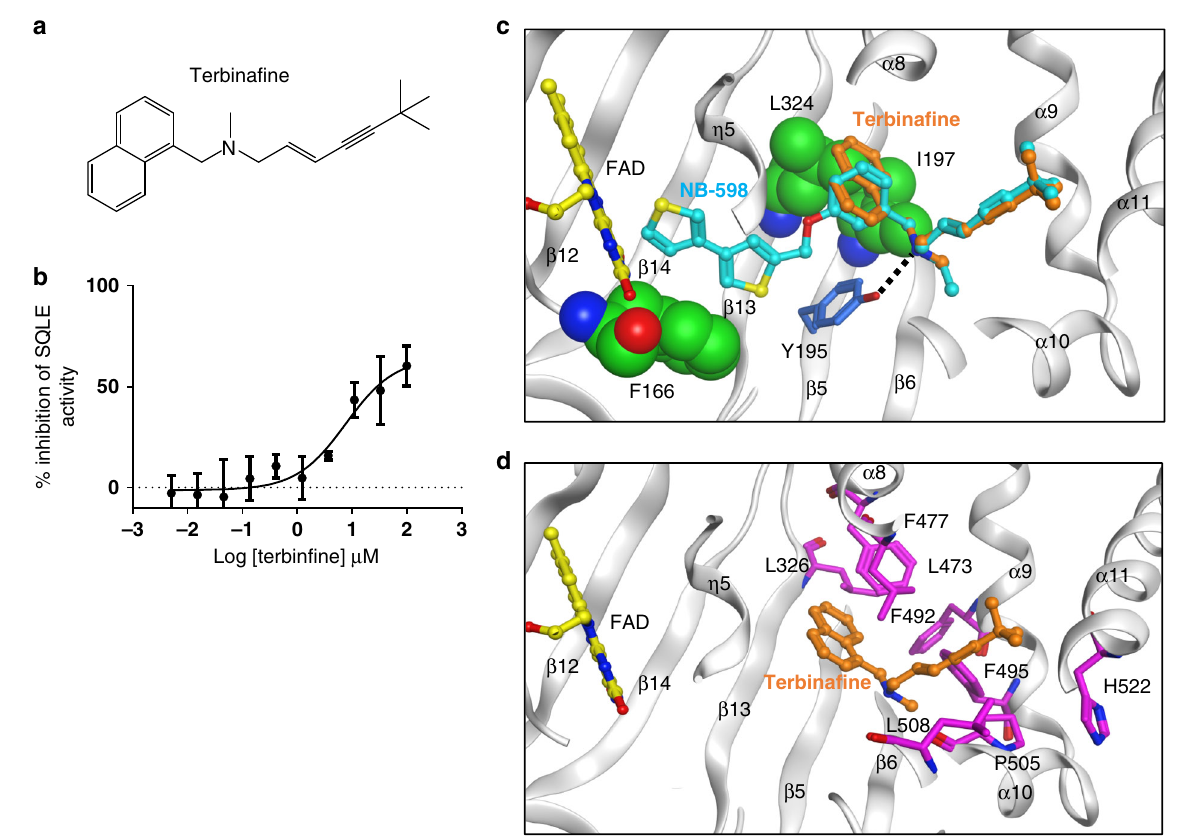
Fig. 3 Biochemical characterization of terbina fi ne, binding model and rationale for fungal drug resistance. a Structure of terbina fi ne. b Terbina fi ne is a weak partial inhibitor of human SQLE in the HLM assay. Relative IC 50 was determined to be 7.7 µ M with a maximal inhibition of 65% at 100 µ M inhibitor concentration. Error bars represent the standard deviations from a representative experiment performed in triplicate. c Superposition of terbina fi ne structural model with NB-598 using the SQLE (cid:129) FAD (cid:129) NB-598 complex. NB-598 (cyan), terbina fi ne (orange), and FAD (yellow) are shown in ball-and-sticks representation. Non-conserved amino acids in the inhibitor binding site is shown in CPK (green) and the Y195 residue that is conserved across species in stick (blue) representation. Hydrogen bond interaction between Y195 and the central amine moiety of inhibitors is shown as black dashed line. d Mapping of terbina fi ne-resistant mutations to the human SQLE structure with superposed terbina fi ne model. Equivalent human residues corresponding to terbina fi ne-resistant mutations identi fi ed in fungi are shown as magenta sticks. FAD (yellow) and Terbina fi ne (orange) are depicted in ball-and-stick representation